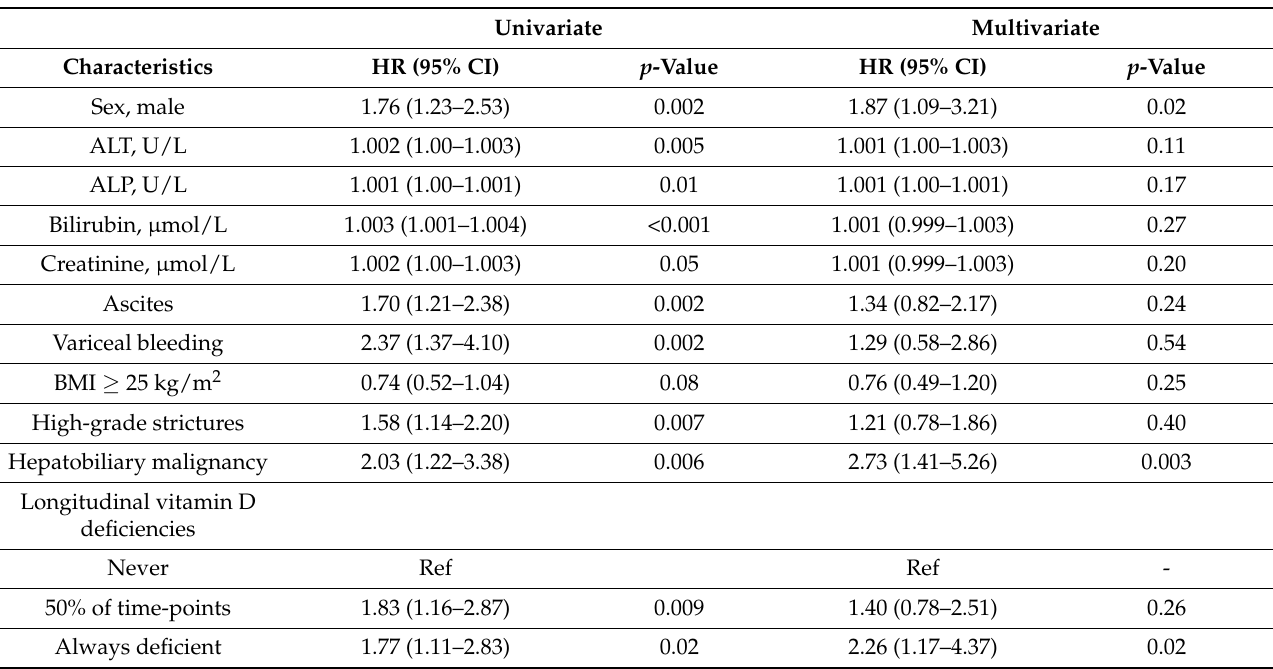
Table 4. Association between Longitudinal Severe Vitamin D deficiency and Liver-Related Events (Mortality and Transplantation).